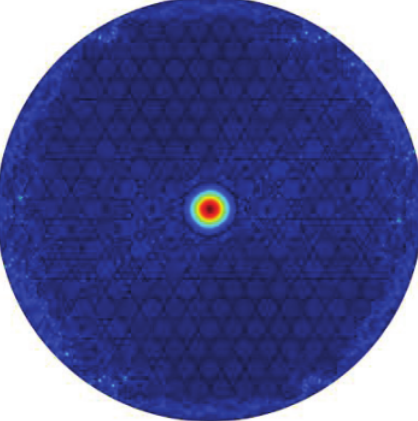
Figure 2: Fundamental mode confinement of the investigated optical